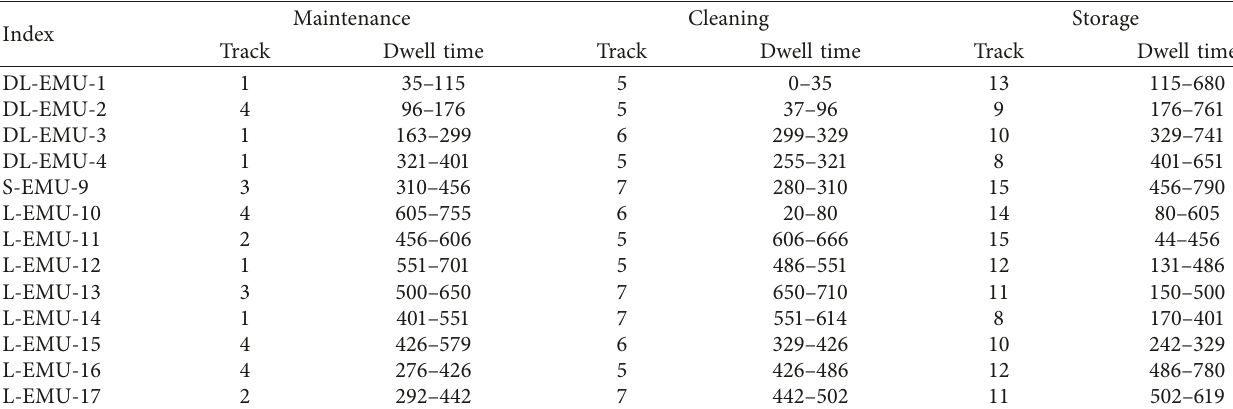
Table 7: The solution data generated by the RVNS